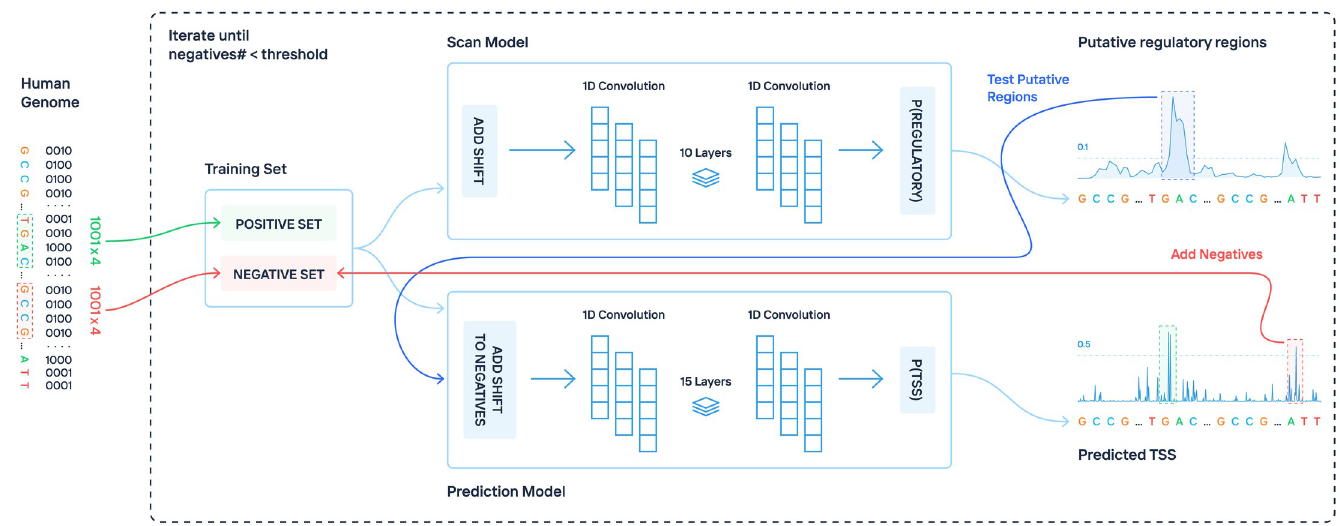
Fig 1. Workflow of the proposed method for genome-wide regulatory elements prediction. The scan model uses a sliding window approach to pick putative regulatory regions. The prediction model finds TSS positions inside these regions by testing each position. The false positive predictions made by the second model are added to the negative set for the next round of training. The whole process is repeated iteratively to generate a difficult negative set which forces the model to learn how to distinguish the difficult negatives from the real regulatory sequences.